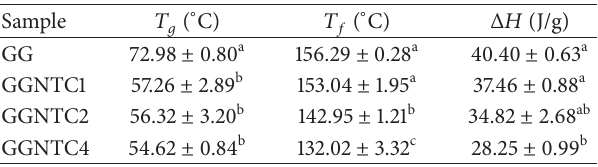
Figure 3: Thermal transitions of films from gelatin/glycerol and carbon nanotubes. (A) GG and (B) GGNTC1; (C) GGNTC2 and (D) GGNTC4. Table 2: Thermal parameters of films from gelatin/glycerol and carbon nanotubes ∗